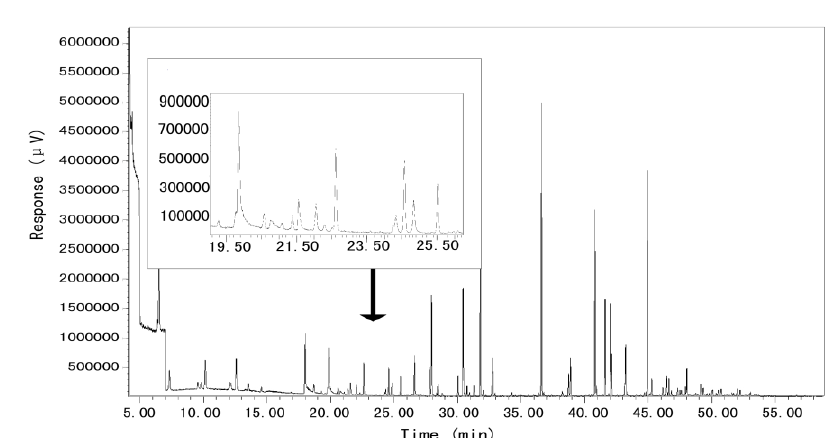
* The correlation coefficients is for the calibrations at four concentrations (0.5, 2.5, 5.0, 10.0 ppbv); DL = detection limit. Figure 2. Typical chromatogram of total VOCs obtained from 06:00 to 09:00 on 2 December 2009 at the Xujiahui sampling